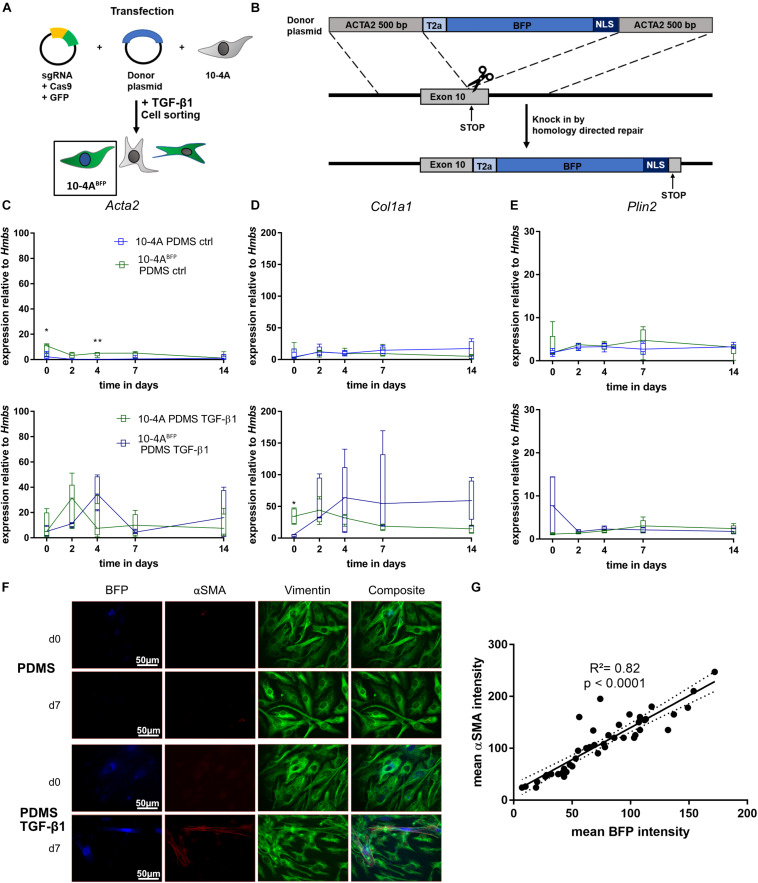
Generation and verification of an Acta2 coupled BFP reporter cell line. (A,B) Schematic representation of 10-4A cell transfection. Cells were transfected with a plasmid containing Cas9 and the sgRNA binding at the desired gene (exon 10) and a donor plasmid. The donor plasmid contained a BFP flanked by a self-cleaving T2A cassette, a nuclear localization sequence and two 500 bp homologous arms of the sgRNA cutting site. After cell transfection, Acta2 gene expression was induced by addition of 5 ng/ml TGF- β1 and cells were FACS sorted for BFP. Semi-quantitative RT-PCR analysis of Acta2
(C), Col1a1
(D), and Plin2
(E) expression in 10-4A and 10-4ABFP cells with and without administration of 5 ng/ml TGF-β1 on a soft PDMS substrate, respectively. Values are means from five individual culture experiments. The respective time points were tested with the non-parametric Mann–Whitney-U-Test. Statistical significance is indicated as follows: p-values < 0.05: *, p-values < 0.01: **. Box plots show data as median values, the boxes represent percentiles, the whiskers indicate the minimum/maximum. (F) Immunofluorescence staining of 10-4ABFP cells seeded on PDMS with and without administration of 5 ng/ml TGF-β1 directly after adherence (d0) or 7 days post-seeding. Cells were monitored for BFP and stained for the mesenchymal marker vimentin (green) and the pro-fibrotic protein αSMA (red). Scale bar = 50 μm. (G) Correlation of the BFP and αSMA signal intensity within individual cells 7 days post seeding. N = 48 cells. A linear regression line and the corresponding indicator R and p-value show the linear dependency of BFP and αSMA signal.